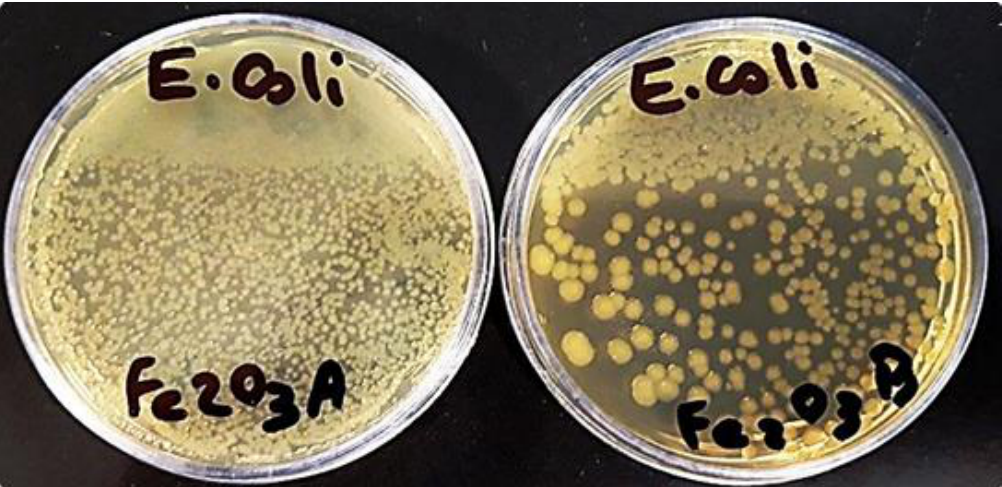
Figure 8. Antibacterial Activity on E. coli Bacterium in the Film (a) α-Fe 2 O 3 prior to Plasma Injection and (b) α -Fe 2 O 3 -P following Plasma